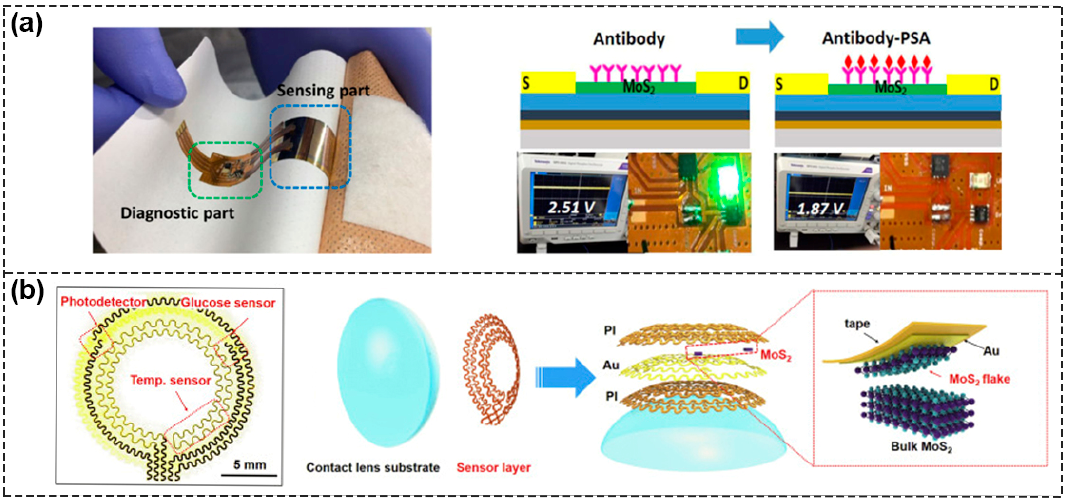
Figure 12. Schematic of multifunctional sensing systems. ( a ) The devices with system − level integration of flexible MoS 2 FET biosensors, read − out circuits and LEDs. Photograph of an epidermal skin − type MoS 2 biosensor system ( left ). Optical images of the LED indicator biochip for PSA detection ( right ). Reproduced with permission from [92]. Copyright 2017, Tsinghua University Press and Springer − Verlag Berlin Heidelberg. ( b ) Optical image of the serpentine mesh sensor system, including a photodetector, a temperature sensor and a glucose sensor, and schematic illustration of the different layers of smart contact lens structure attached to an eyeball. Reproduced with permission from [93]. Copyright 2021, Elsevier Inc.